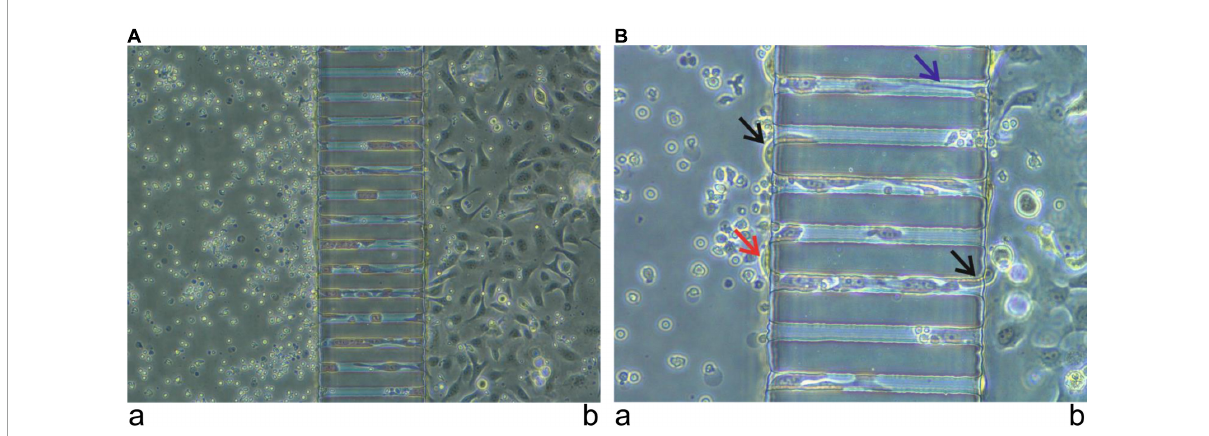
FIGURE3 Simulation of metastasis using a microfluidic chip. Immune cells from a healthy donor, provided by the Finnish Red Cross, were injected into the channel (a) and oral tongue squamous cell carcinoma cells (HSC-3) were injected into the channel (b). After 24 h, cancer cells started to pass from channel (b) to channel (a) using the micro-channels. Images were taken using 20 × (A) and 40 × (B) magnification. Cells entering and leaving the micro-channels (black arrow). Cells attempting to communicate inside the microchannel (blue arrow). Cells successfully passed from channel (b) to channel (a) (red